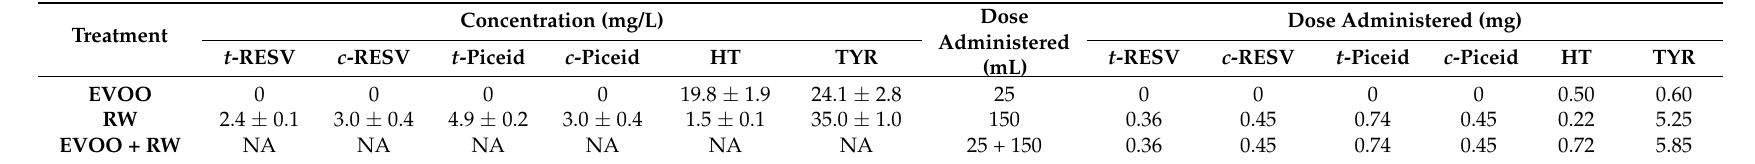
Table 1. Phenolic content of EVOO, RW, and administered